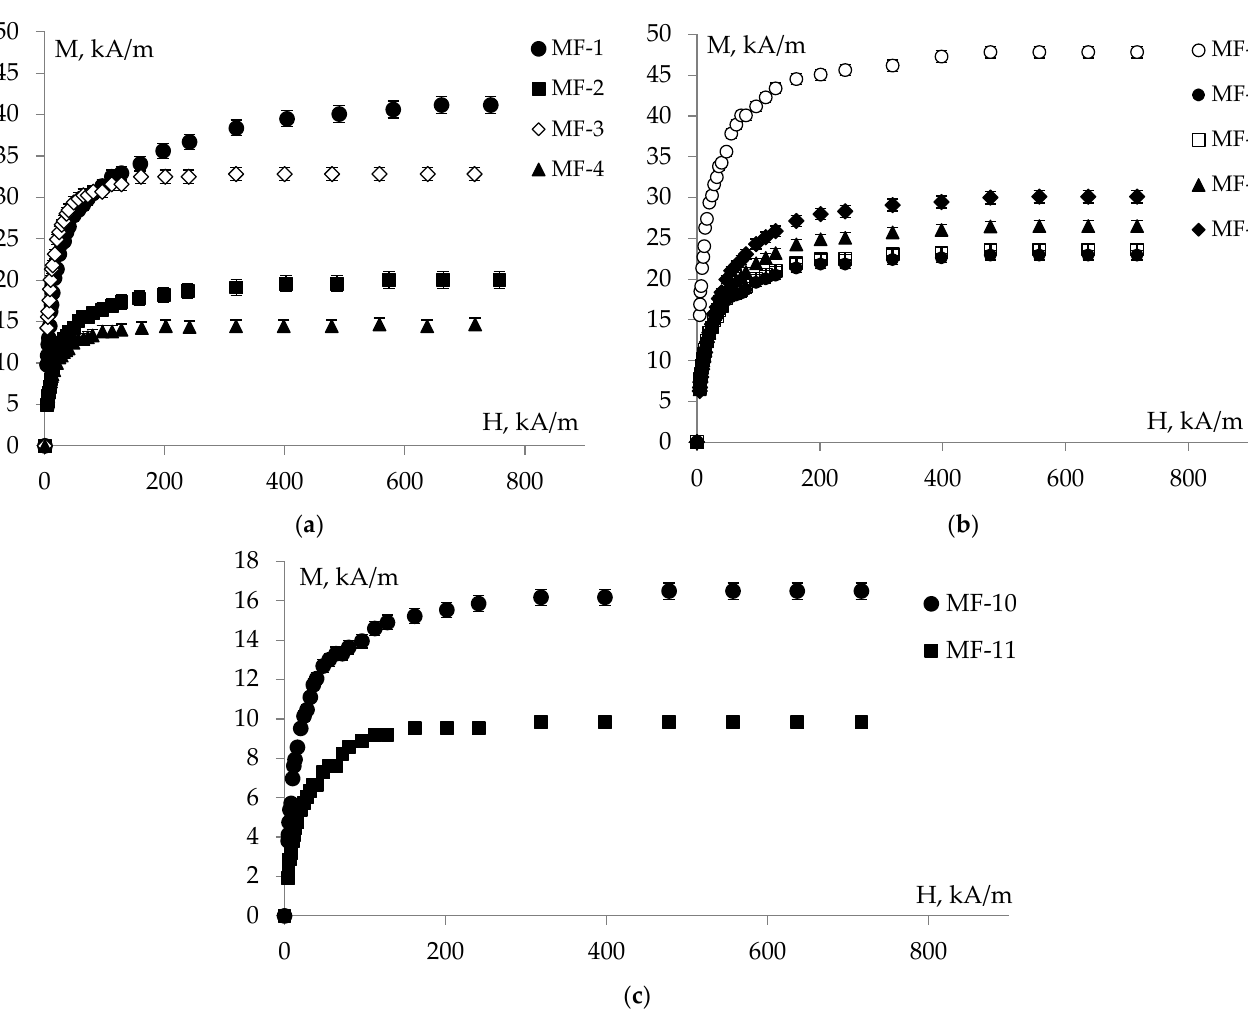
Figure 2. Sample magnetization curves: ( a ) MF-1–MF-4, ( b ) MF-5–MF-9, ( c ) MF-10–MF-11.